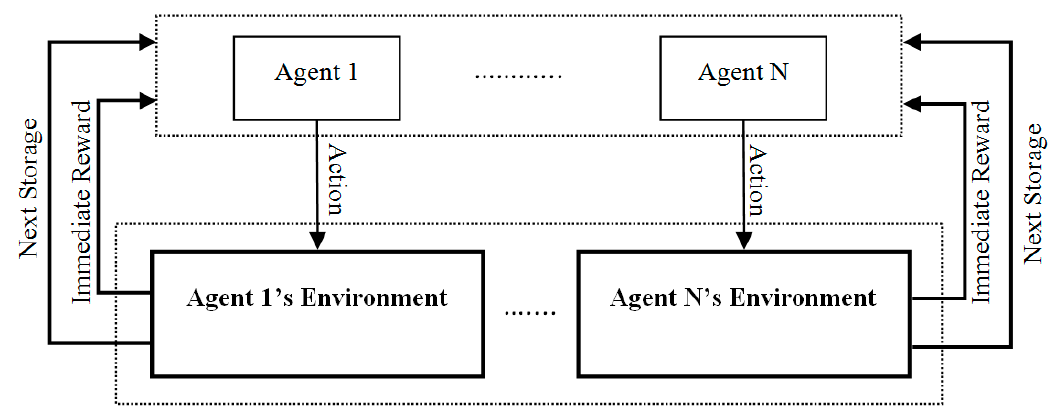
Figure 2. Schematic of aggregation / decomposition reinforcement learning (AD-RL) algorithm.